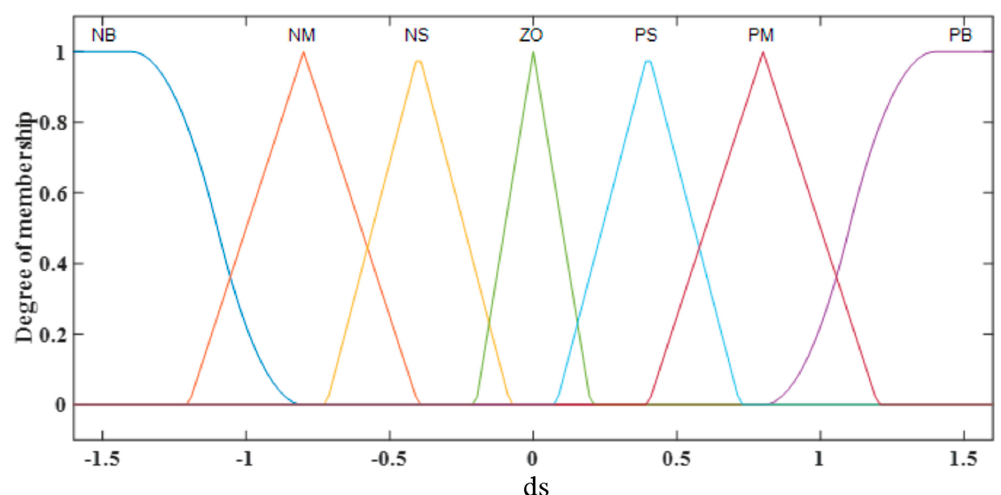
Figure 9. The ds membership function diagram.